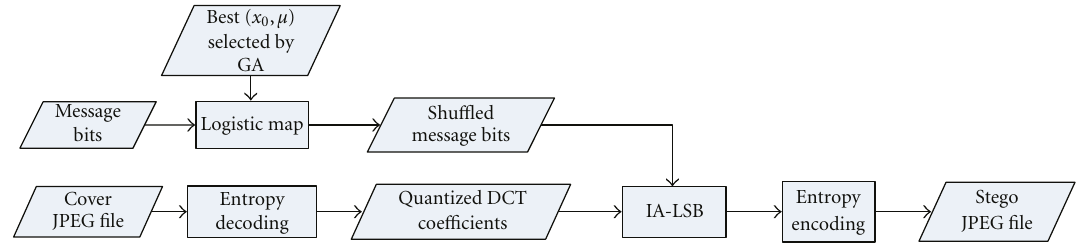
Figure 3: Embedding procedure of our proposed method.